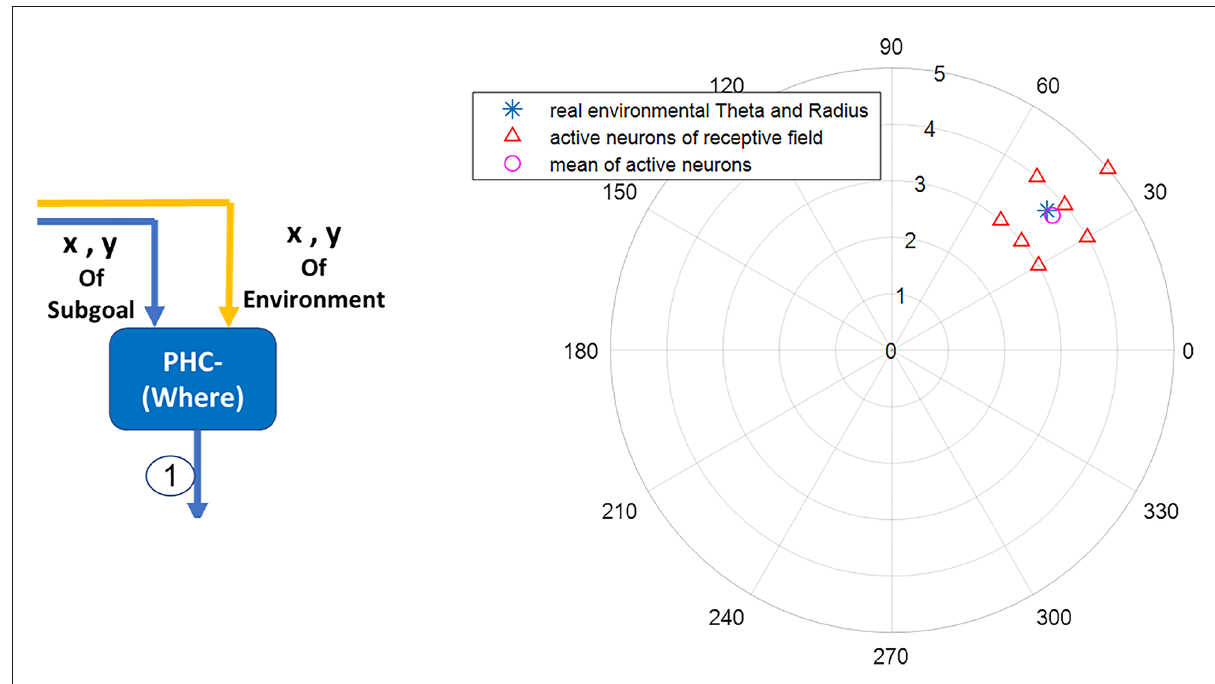
FIGURE4 The blue star denotes the landmark’s real coordinates relative to the agent’s body axis. The red triangles denote the activated neurons in the parietal region responsible for the acquisition and processing of egocentric information. The average activity of polar neurons (the pink circle) represents with negligible error the perceived coordinates information of the blue star (the real landmark coordinates) within the environment.